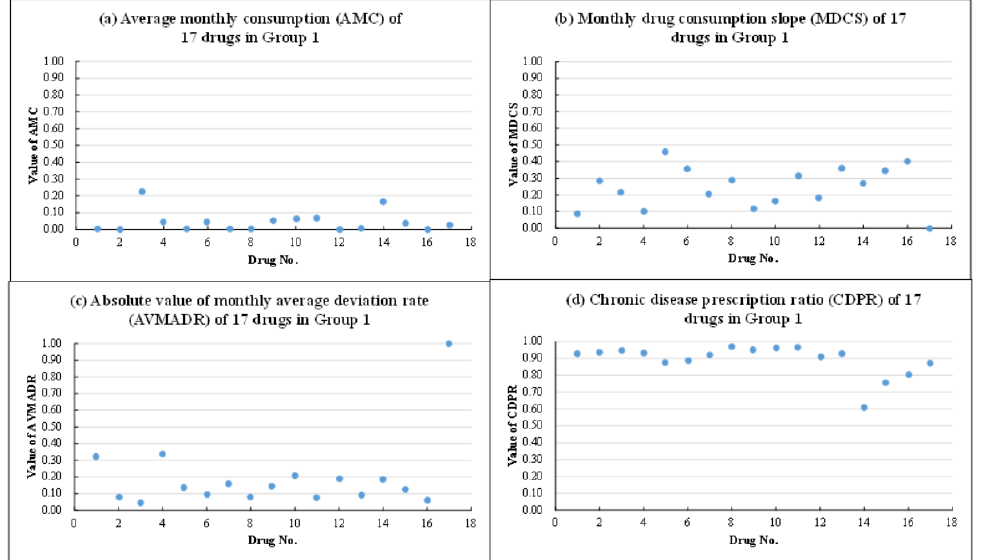
Figure 6. Four indicators of Group 1.